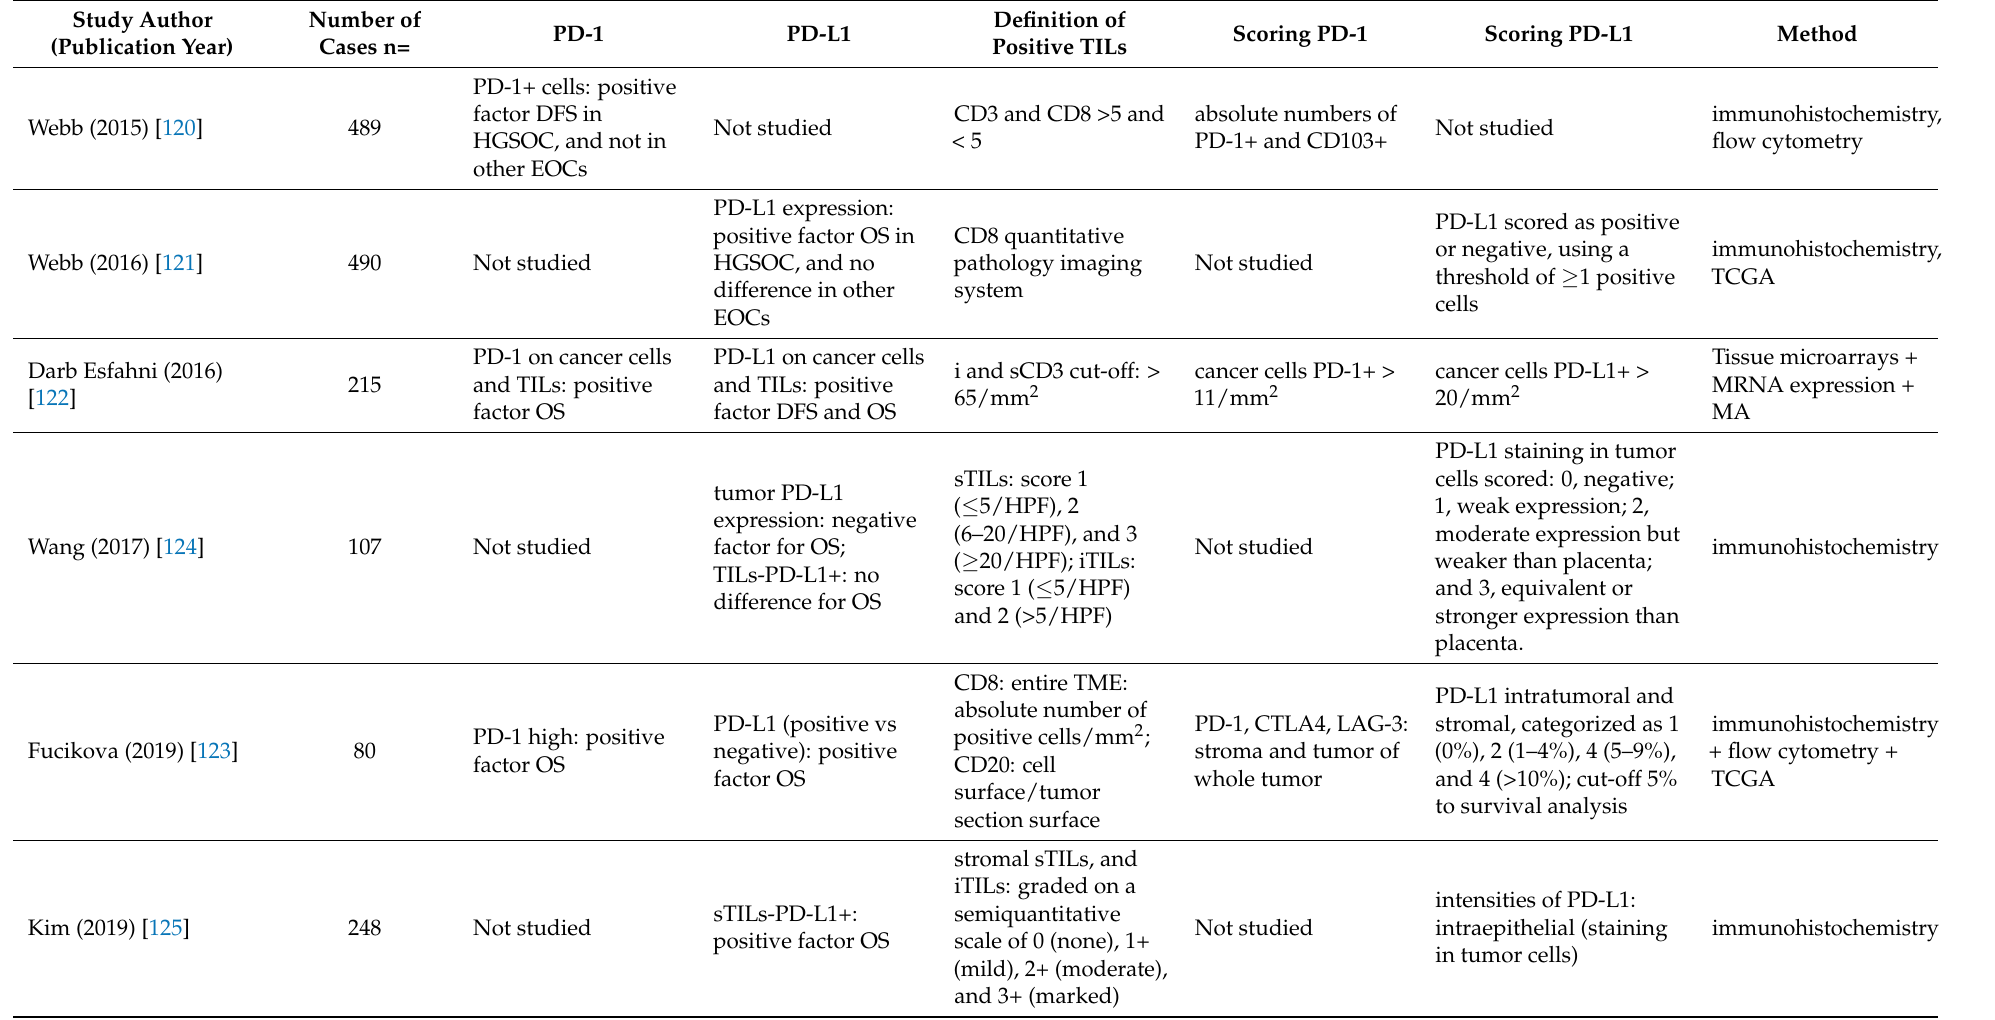
Table 3. TILs and immune checkpoints in the reviewed